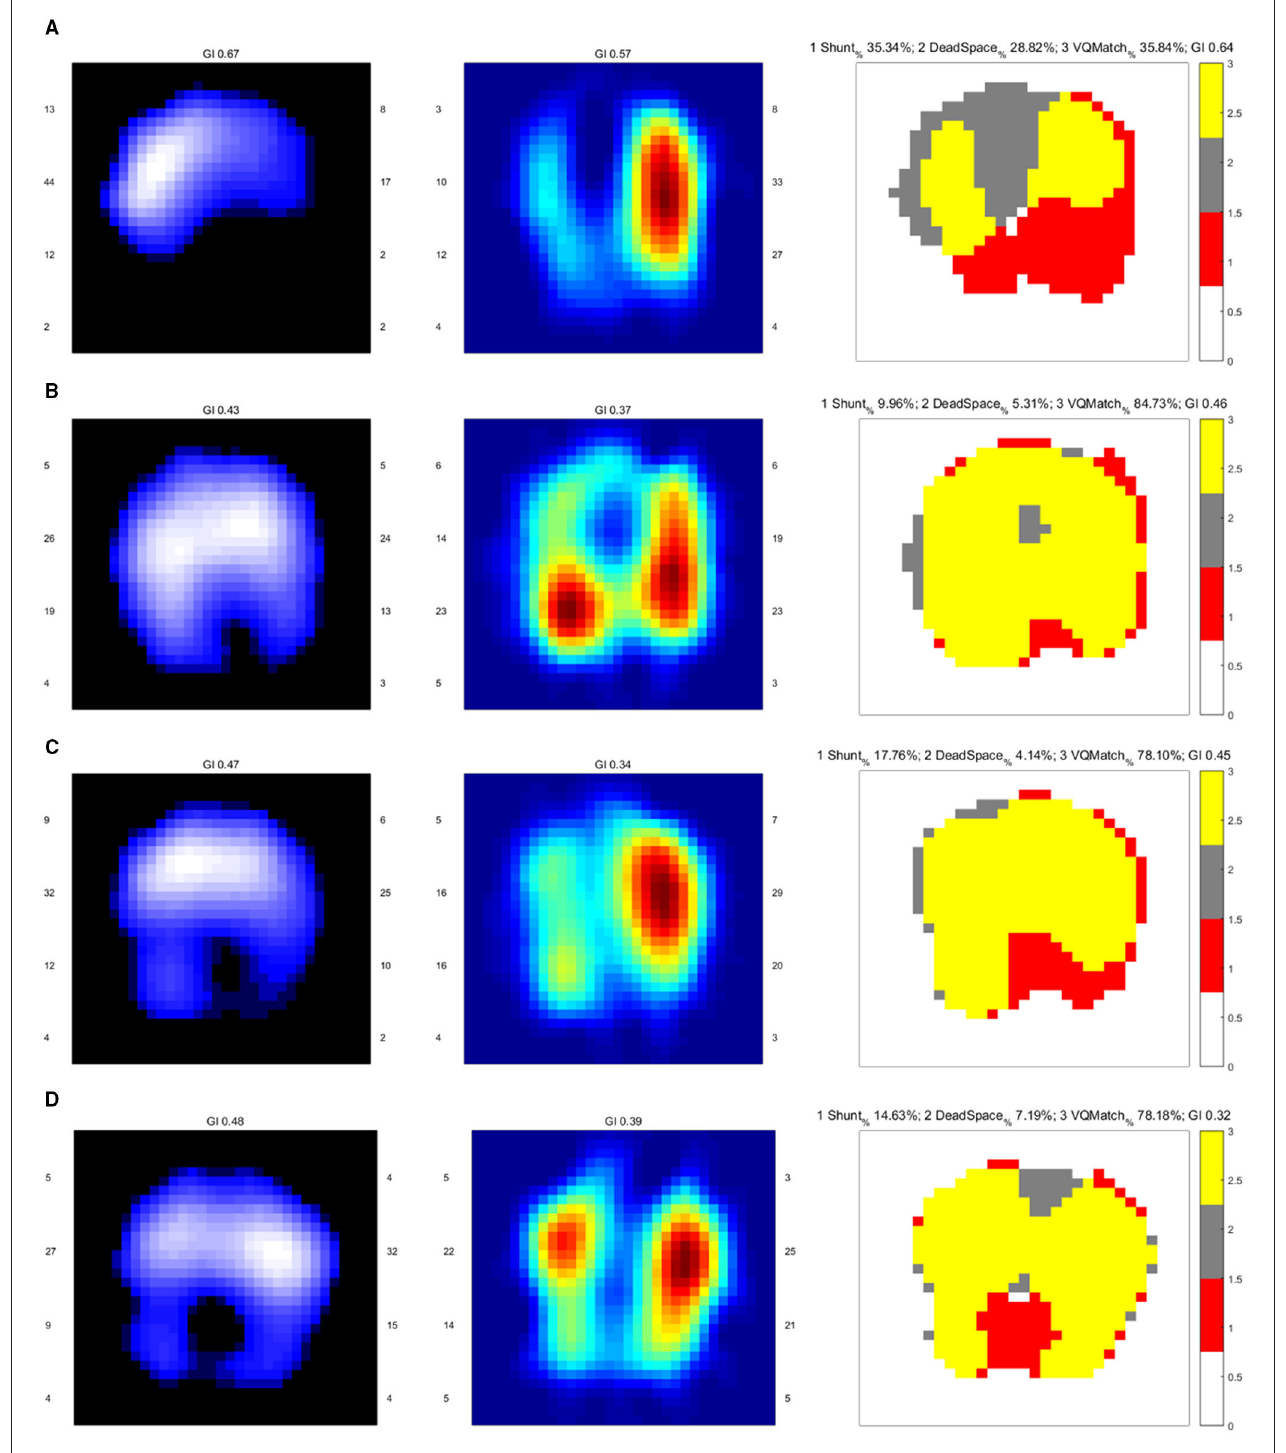
FIGURE 1 | EIT images of the functional ventilation distribution (dark blue areas indicated low ventilated regions and white areas indicated high ventilated regions), functional perfusion distribution (red areas indicated high-perfusion regions and blue areas indicated low-perfusion regions), and distribution of the regional ventilation/perfusion ratios (Ventilated regions were defined as pixels with impedance changes higher than 20% of the maximum tidal impedance variation in the functional ventilation image. Perfused regions were defined as pixels higher than 20% of the maximum bolus-related impedance change in the functional perfusion image. Gray areas indicated regions with high ventilation and low perfusion. Red areas indicated low ventilation and high perfusion regions. Yellow areas indicated good ventilation-perfusion matching). (A) On admission, there was a significant ventilation defect in the dorsal lung and perfusion defect in the right lung, leading us